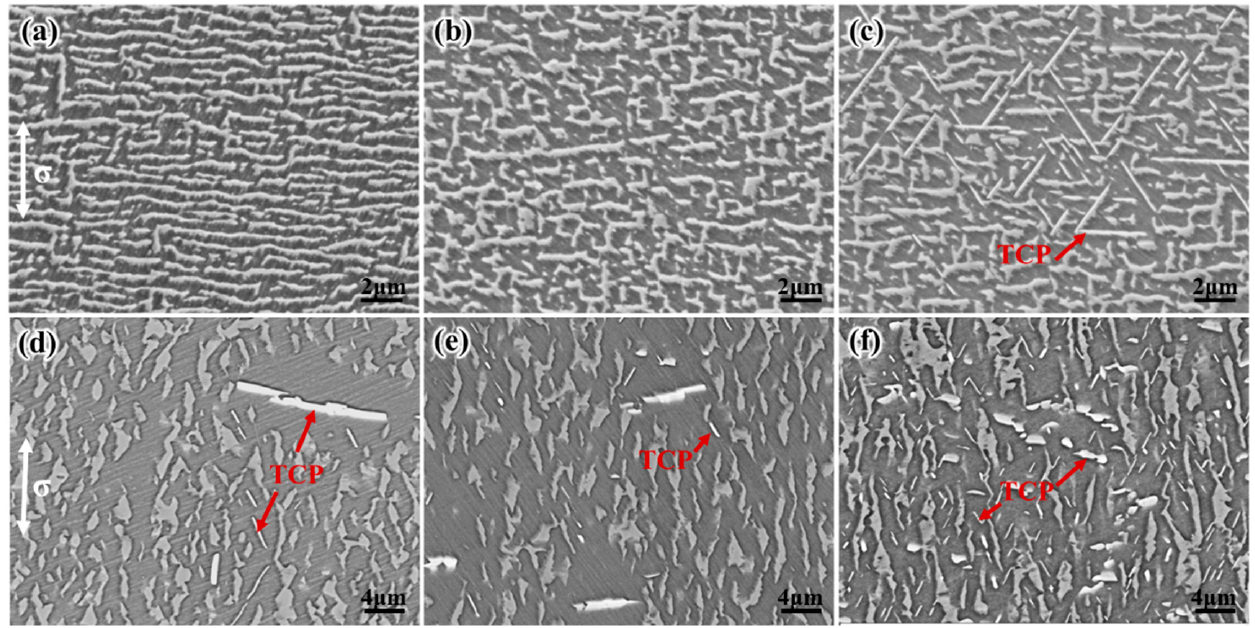
Figure 12. The microstructure of different samples after creep testing under 1100 °C/137 MPa: ( a – c ) interrupted for 10 h, ( d – f ) ruptured; ( a , d ) WQ sample, ( b , e ) AC sample and ( c , f ) HT sample (the loading direction is shown by the arrow).